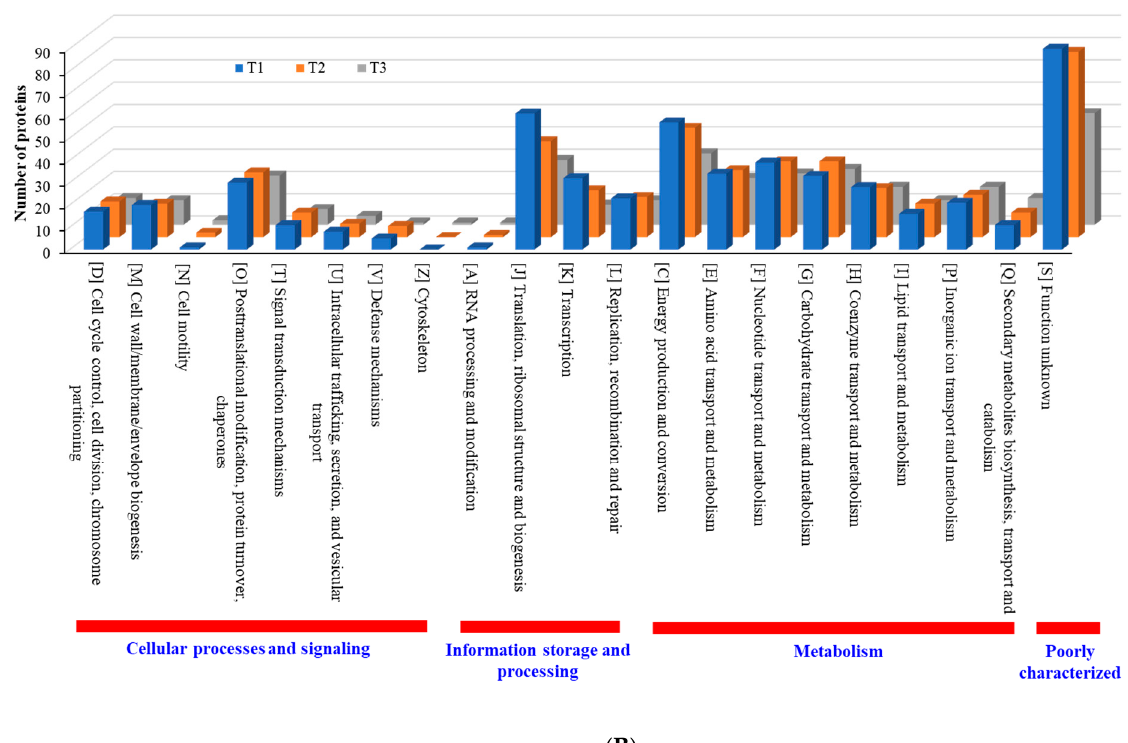
Figure 9. Detailed COG functional classification in differentially expressed proteins identified from S. epidermidis strain RP62A biofilms grown with sublethal MIC of TC. ( A ): upregulated proteins, ( B ): downregulated proteins, T1: 1/8 MIC, T2: 1/4 MIC, T3: 1/2 MIC.